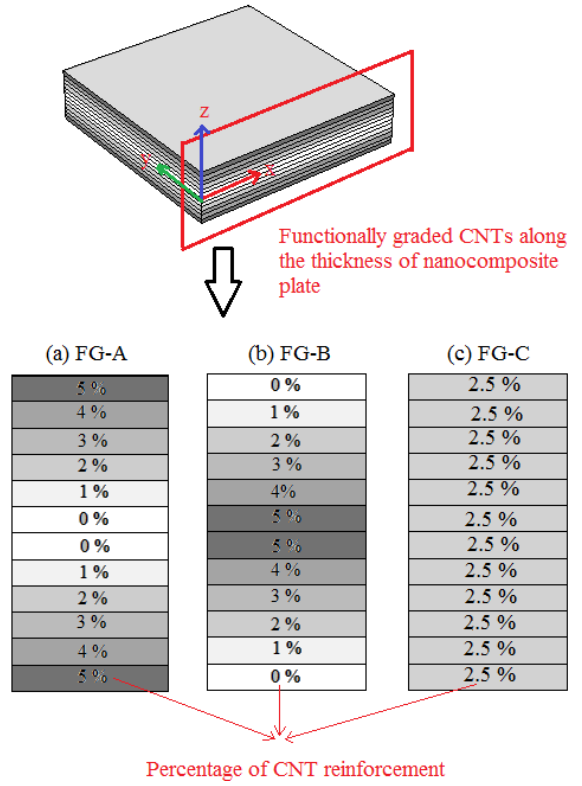
Fig. 6: Modeling of actual FG-CNT-reinforced nanocomposite plate into a laminate composed of multiple perfectly-bonded nanocom- posite